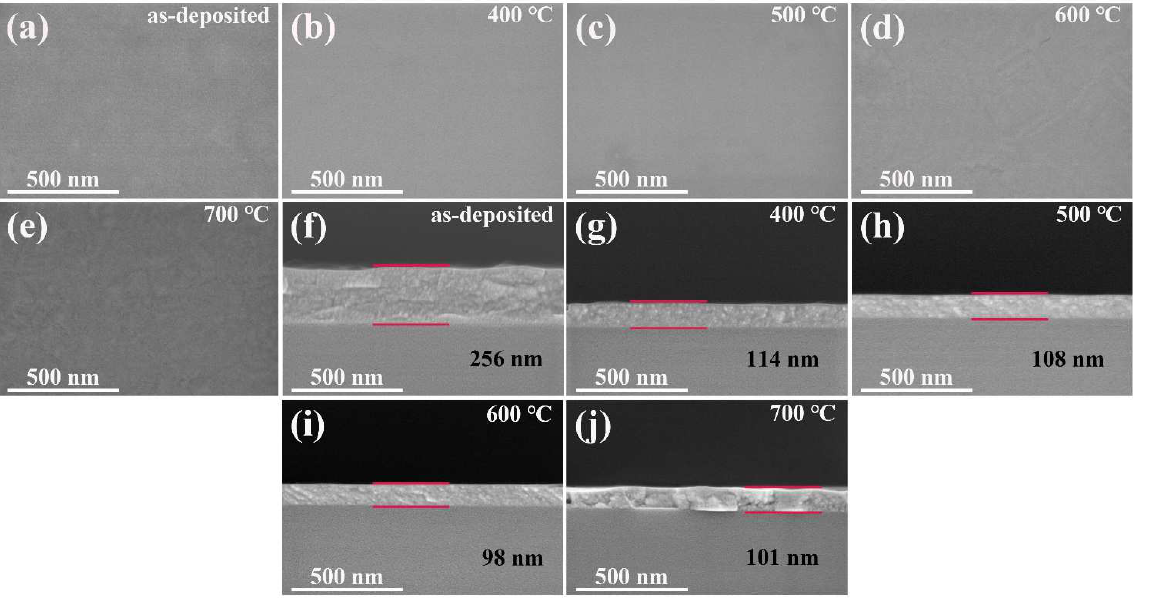
Figure 4. ( a – e ) SEM images of lanthanum-doped HfO 2 thin films at different temperatures. ( f – j ) SEM cross-sectional topography images at different temperatures.